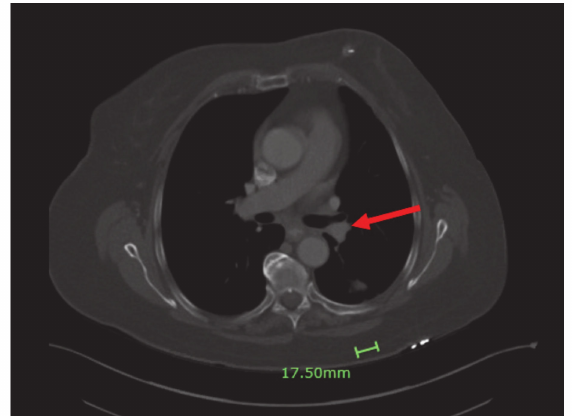
Figure 4. Significant regression of the left lower lobe bronchial tumor (red arrow) and re-expansion of left lower